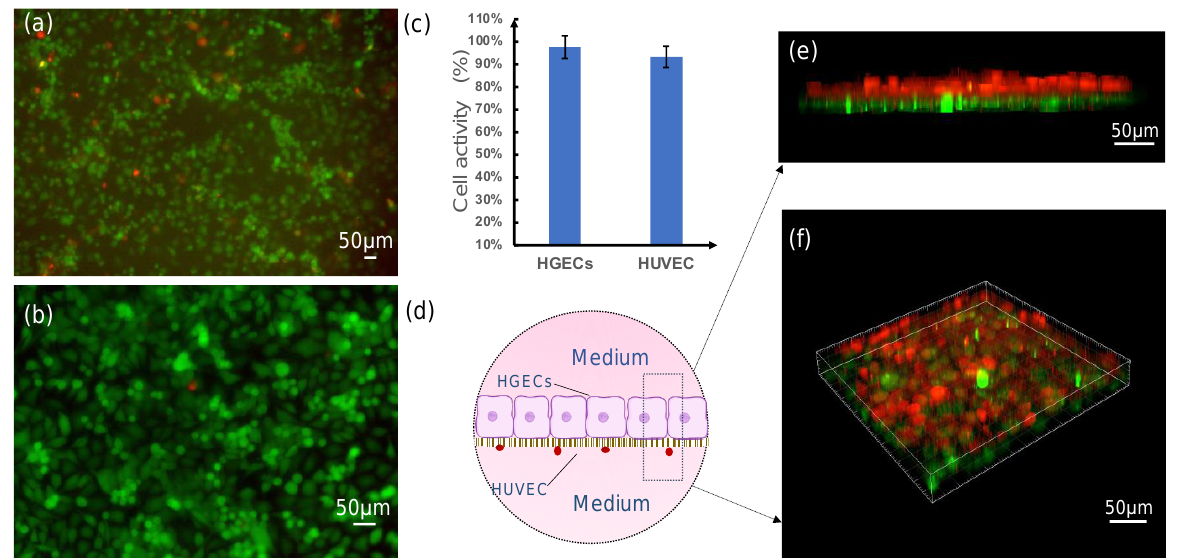
Figure 5. On-chip formation of an epithelium-capillary interface. ( a , b ) Live/dead stain (green: live, red: dead) of HUVEC and HGEC cells on day 3 of culture on the porous membranes. ( c ) Statistical analysis of cell viability. ( d ) Three-dimensional schematic diagram and ( e , f ) reconstructed views of interface formed by HUVEC and HGECs cells on the top PETE membrane tracked by celltracker TM orange (HGECs) and celltracker TM green (HUVEC).